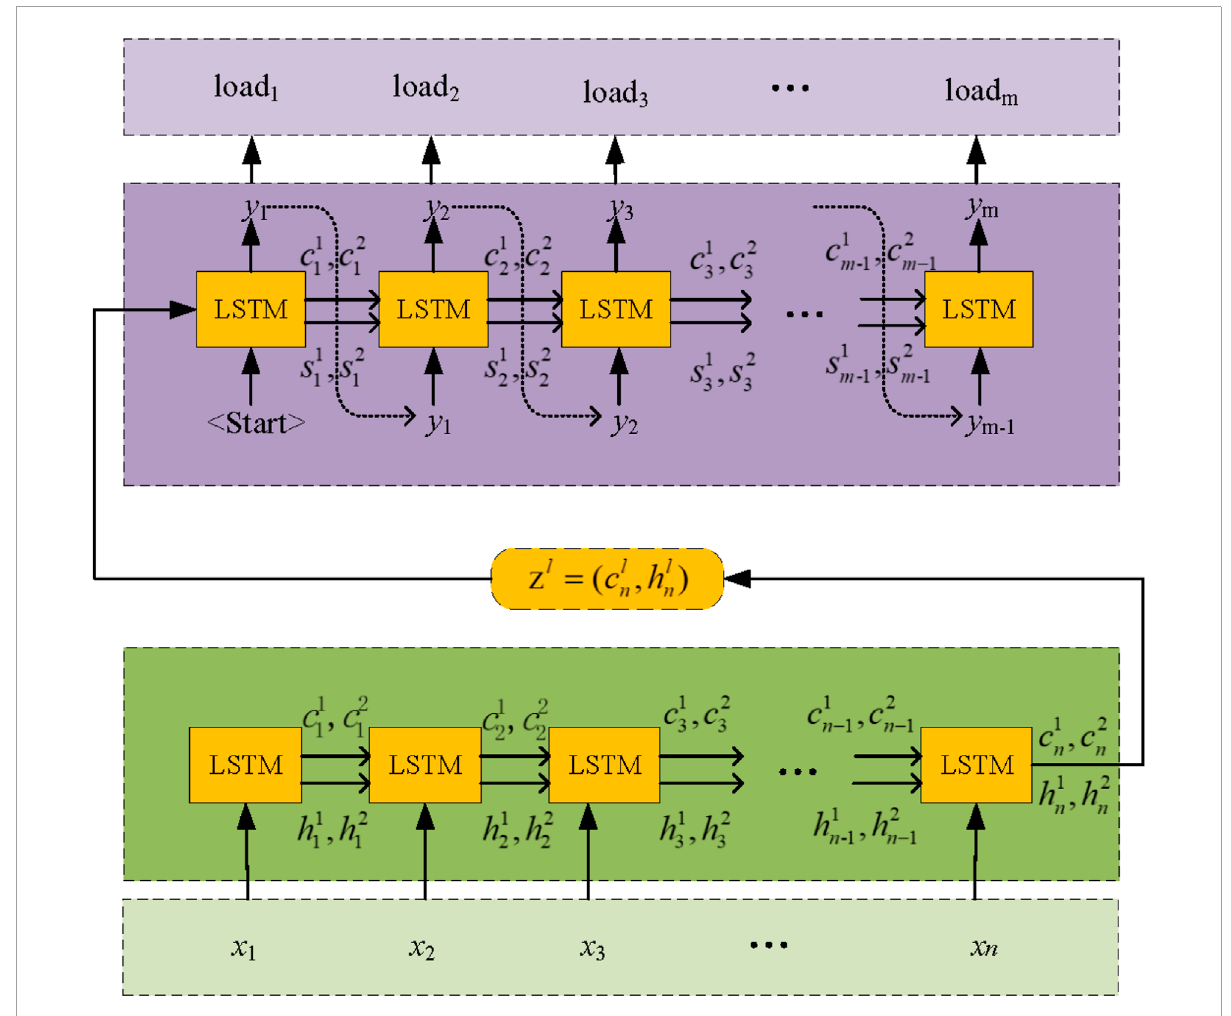
FIGURE 6 The framework of the LSTM-Seq2Seq